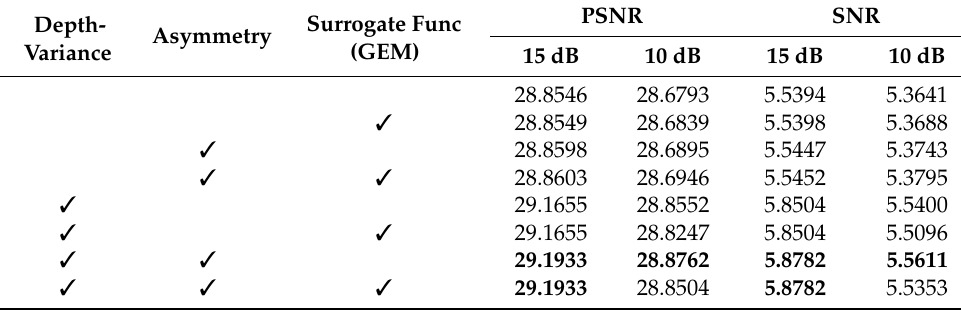
Table 1. Peak signal-to-noise ratio (PSNR) and signal-to-noise ratio (SNR) results. Depth-